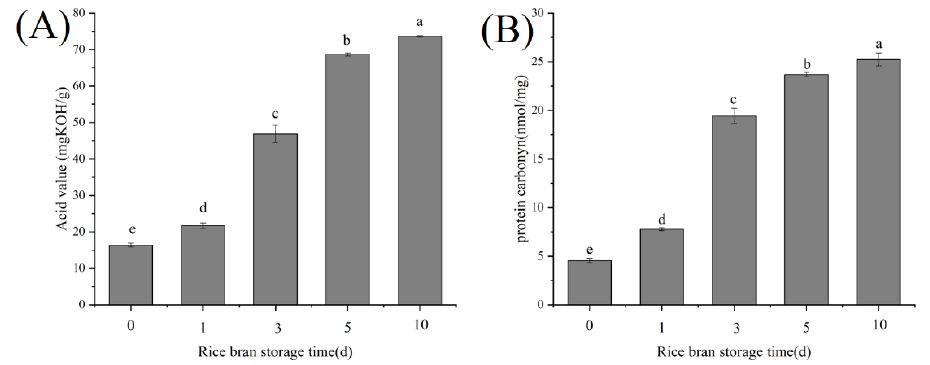
Figure 1. Effects of RB storage time on the acid value of RB crude oil ( A ) and RBP carbonyl content ( B ), different lowercase letters within a column indicate significant differences ( p < 0.05).